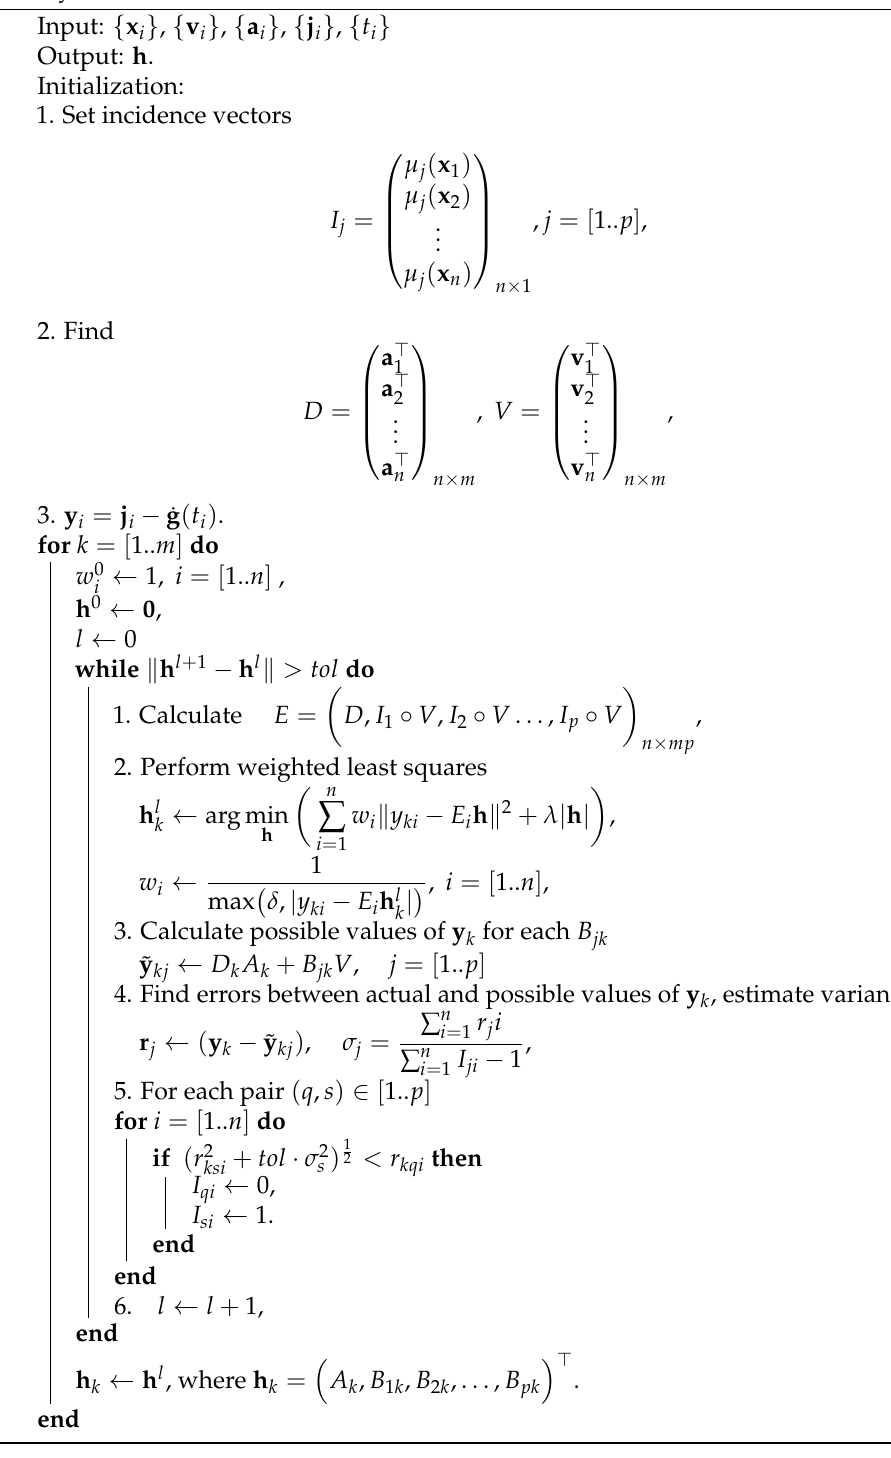
Algorithm 3: IDA for parametric identification of piece-wise linear